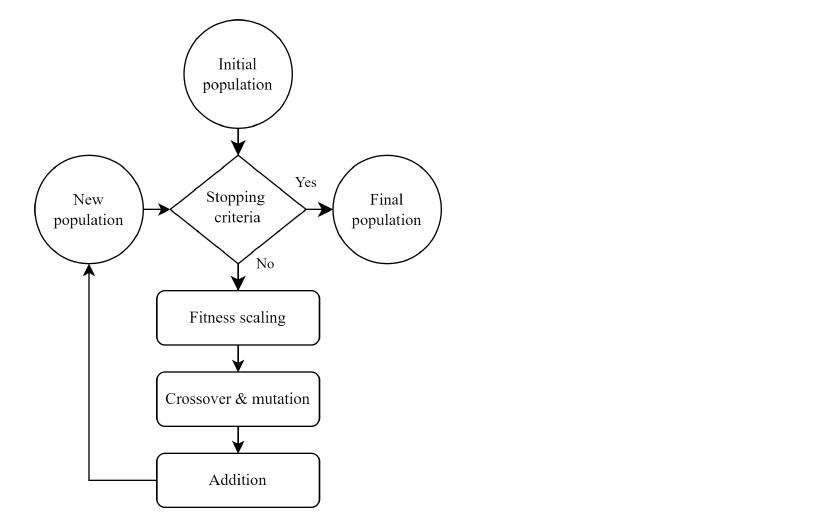
Figure 8. Scheme of the structure of the Cumulative Multi-Niching Genetic Algorithm. Table 4. The CMNGA main parameters and their